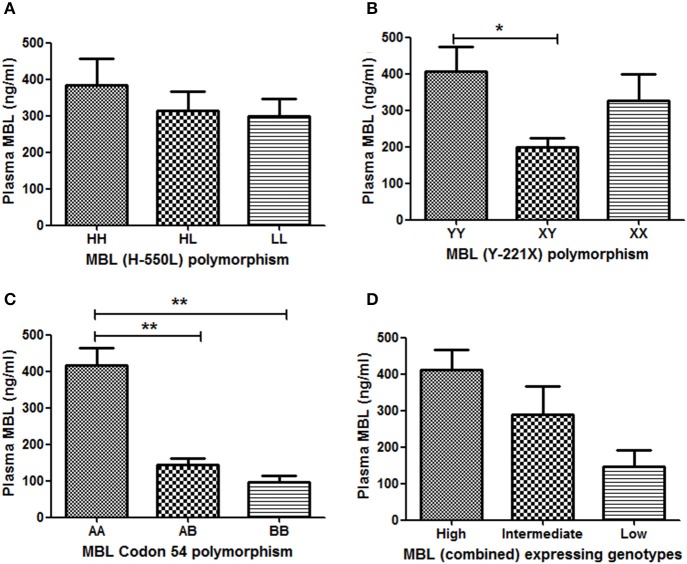
Association between
MBL2
polymorphisms and plasma MBL levels. Plasma concentrations (mean ± standard deviation) of MBL were measured, using a commercial kit. Based on availability, plasma of 84subjects were quantified and correlated with their respective genotypes (A: codon 54 A/B, B: Y-221X, and C: H-550L). Combined genotypes were grouped in to higher (HYA/HYA, HYA/LYA, HYA/LXA, LYA/LYA, and LYA/LXA), intermediate (HYA/LYB, LYA/LYB, and LXA/LXA) and lower expressing (LXA/LYB, LYB/LYB, and LXB/LXB) genotypes (D). Mean plasma levels of MBL among genotypes were compared by ANOVA followed by turkey's multiple comparison post-test. P-value less than 0.05 was considered as significant. *P < 0.05; **P < 0.01.